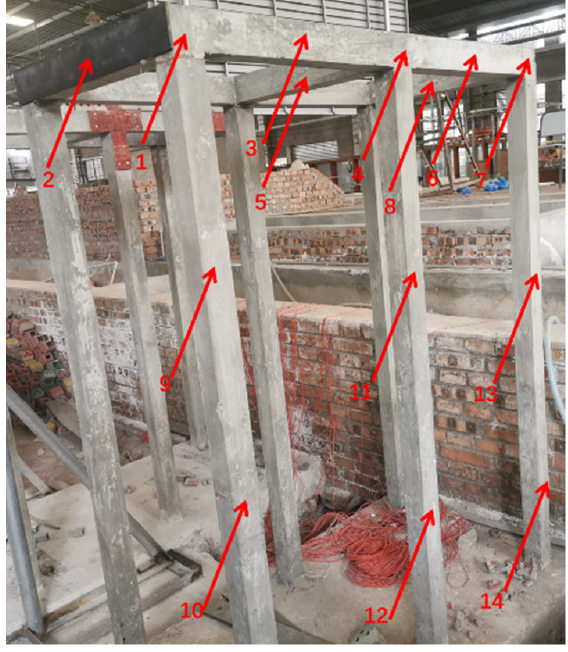
Figure 11. Location of response points in the test model. The external natural excitation (ship impact load) was simulated by pendulum impact. Prior to the formal test, a WMS-6303 magnetoelectric pressure sensor was used for test so as to ensure that the test conditions were met. The test instrument was DH5922 dynamic digi- tal acquisition system produced by Jiangsu Donghua Test Technology Co., LTD, Jingjiang City, Jiangsu Province, China, and the sensor was DH1A213E magnetoelectric acceleration sensor. The above instruments were used to collect the acceleration response data of the frame and draw the time-history curves during repeated crash tests. In order to distinguish the difference of dynamic response parameters of wharf frame structure before and after damage, the model of undamaged wharf frame was reinforced with wood riveting. When sensors were installed on the frame structure, the test was performed in two batches due to the limitation of the number of sensors. Intact structure and damaged structure were taken as one batch respectively. Each lot was divided into three sub-lots. The front, middle, and rear racks were tested as a sub-lot. Apart from that, the pendulum was calculated to strike the frame load surface at a fixed angle. The impact surface was wrapped with rubber to simulate the force of the ship member. Test photos are shown in Figure 12 as